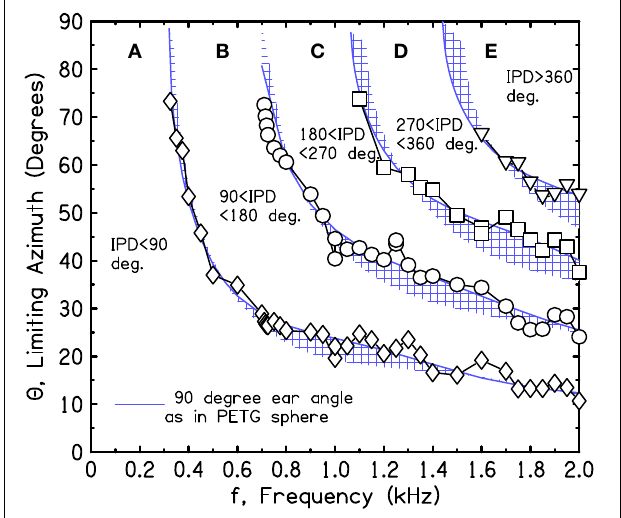
FIGURE 4 | Measured values of frequency and azimuth that lead to IPDs of 90 ◦ , 180 ◦ , 270 ◦ , and 360 ◦ (diamonds, circles, squares, triangles, respectively) for a perfect sphere. Values were interpolated from measurements using a source array in one